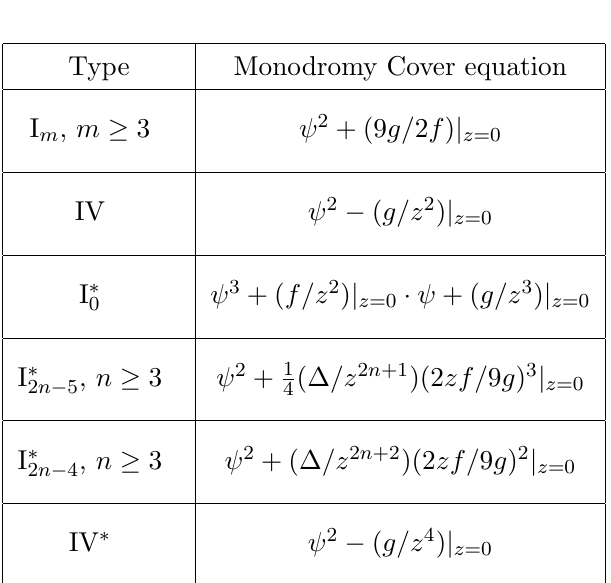
Table 2. Top: summary of Kodaira singularities and corresponding non-abelian gauge algebras for F-theory seven-branes. Bottom: monodromy covers for (cid:6) using adapted coordinates in which (cid:6) is the locus f z = 0 g in the F-theory base.